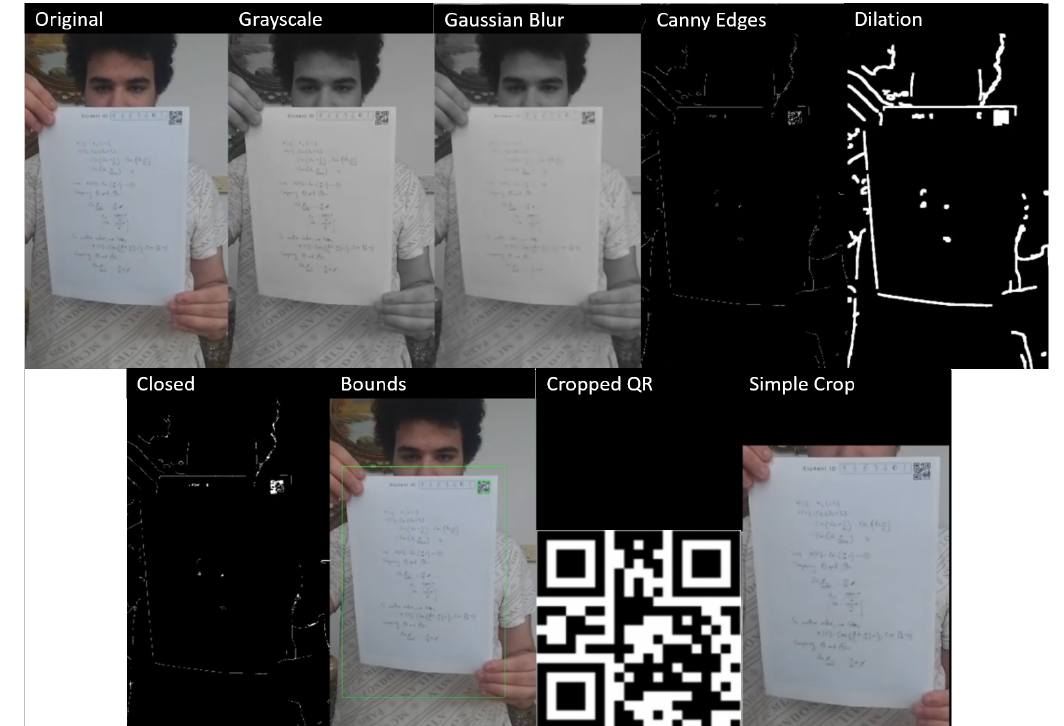
Figure 9. QR detection algorithm pipeline.